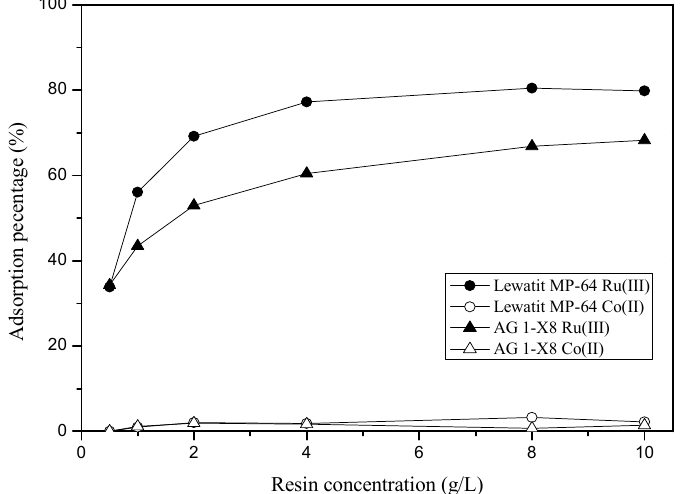
Figure 8. Effect of resin concentration on the adsorption of Co(II) and Ru(III) onto AG 1-X8 and Lewatit MP-64. ([Time] = 6 h, [Co(II)] = 100 mg/L and [Ru(III)] = 10 mg/L). Loading capacity of AG 1-X8 and Lewatit MP-64 for Ru(III) was measured by consecutively contacting fresh aqueous solutions. In these experiments, the concentration of the resins was fixed at 0.5 g / L. Figure 9 shows the cumulative mass of Ru(III) loaded into the two resins. The loading capacity of AG 1-X8 and Lewatit MP-64 was determined to be 27.1 and 28.7 mg of Ru(III) by 1 g of resin, respectively.